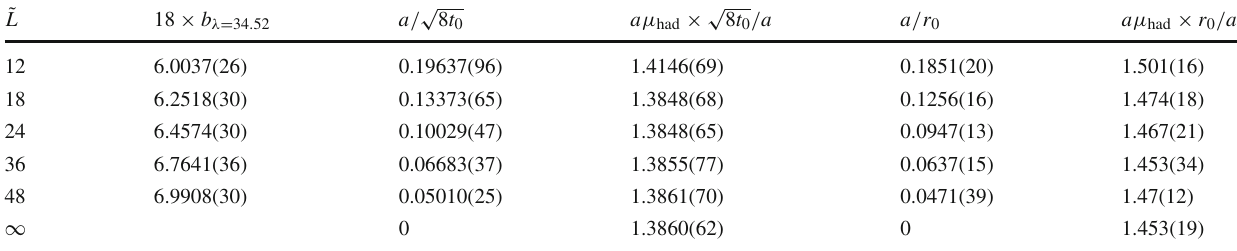
Table 4 Values of the bare coupling, lattice spacing and reference scales μ had λ(μ ) = 34 . 52 ( 29 ) – see had